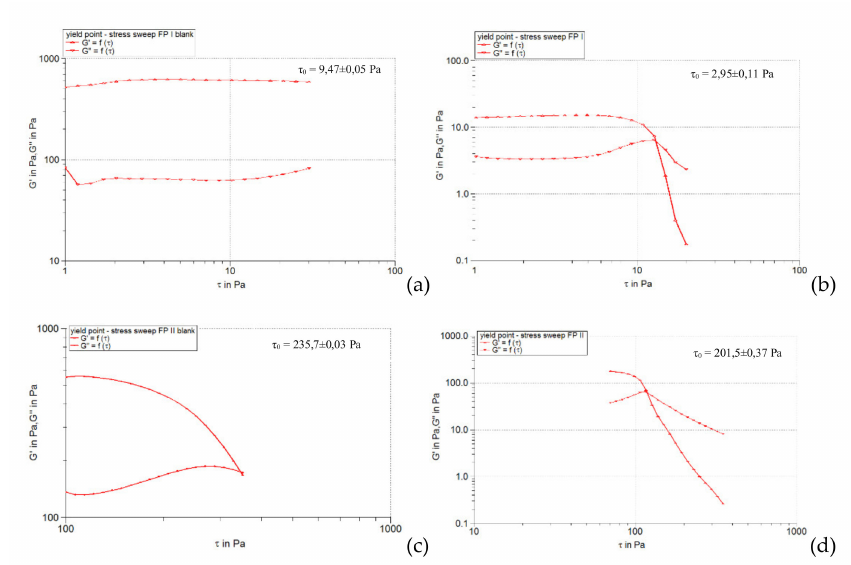
Figure 9. G’ and G” modulus curves as a function of stress at 1 Hz for Carbopol 940 and propylene glycol-based hydrogels, simple or loaded with caffeic acid liposomes: ( a ) FPI blank, ( b ) FPI, ( c ) FPII blank, ( d ) FPII.